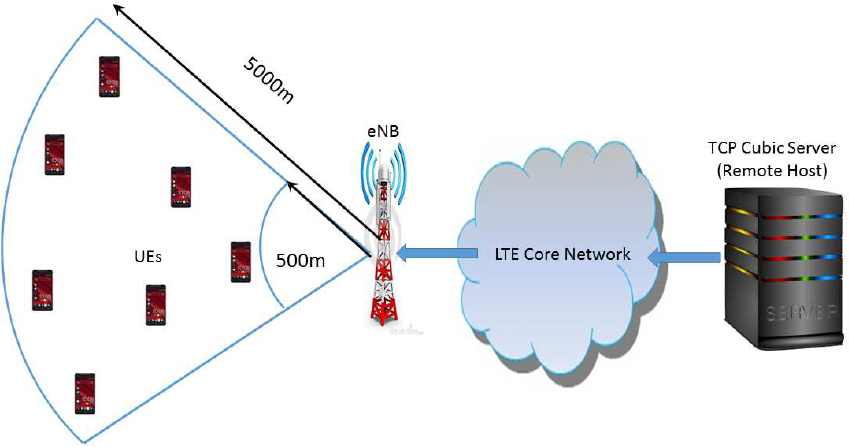
Figure 6. Single-cell LTE network topology.